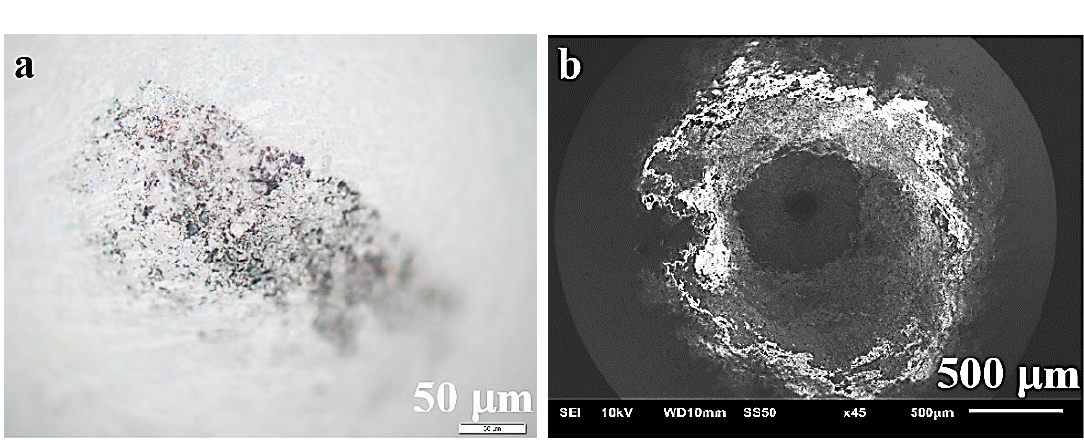
Figure 13. Ball surface at the point of friction/contact with the composite surface after the ball-on-disc friction process: ( a ) optical microscope, ( b ) SEM.